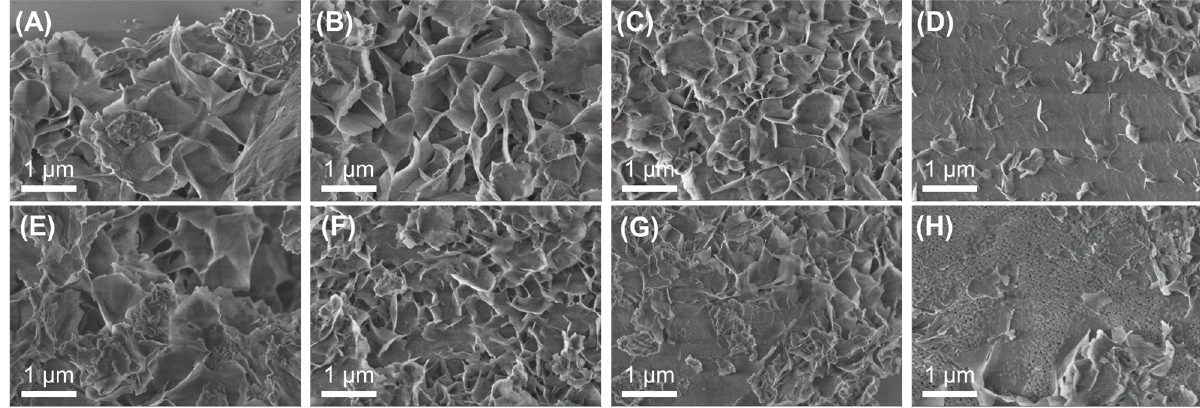
Figure 4. Scanning electron micrograph images of AuCM samples ( A – D ) before and ( E – H ) after H 2 treatment: ( A , E ) AuCM (450), ( B , F ) AuCM (600), ( C , G ) AuCM (750), and ( D , H ) AuCM (1000).